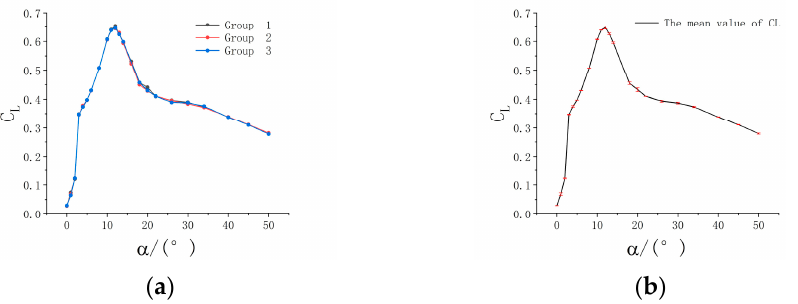
Figure 9. Comparison of three static experimental lift coefficients at reverse-blowing. ( a ) Three sets of lift coefficient curves, ( b ) lift factor error bars.